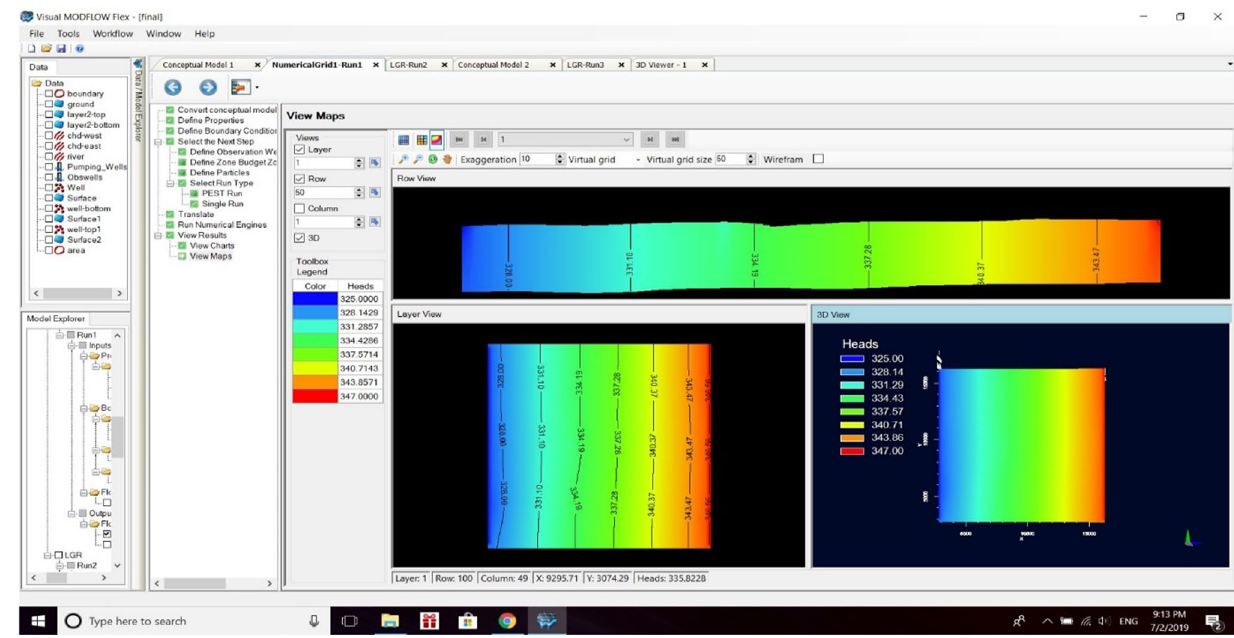
Fig. 13 Groundwater level head simulation of Layer-1 using numerical modeling